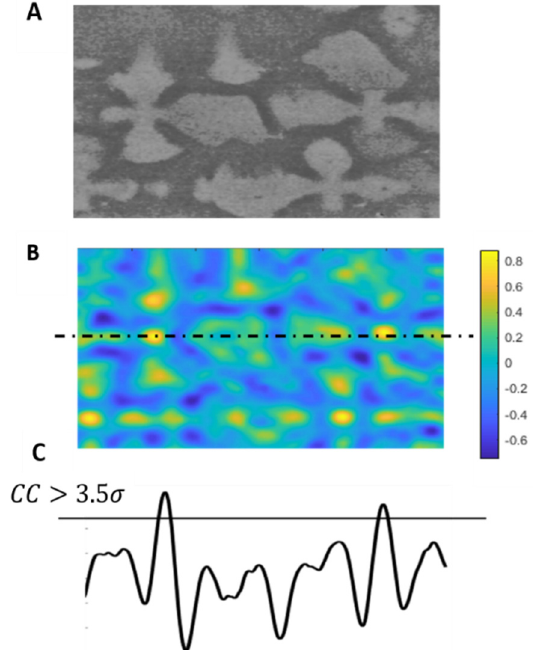
Figure 6. ( A ) Original segment of an image of interest (IOI) image, ( B ) NCC output pattern for a window of size 400 by 500 pixels. ( C ) A representation of the correlation function across the section line, where the correlation coefficients higher than 3.5 σ identifies only the dendrite cores. Neighbouring peaks correspond to secondary dendrite arms but they are under the thresholding value and not identified.